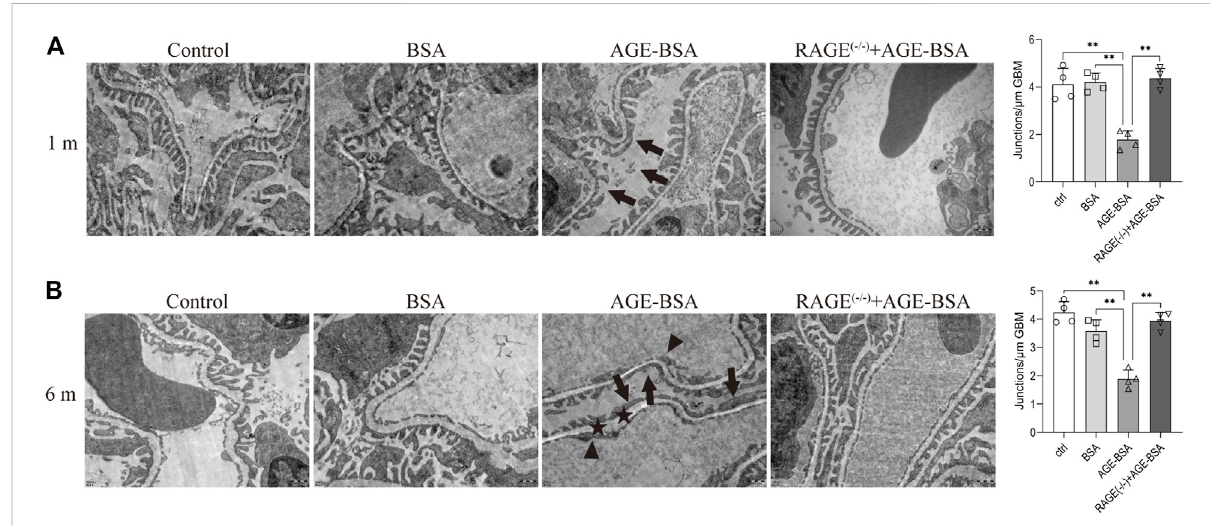
FIGURE 3 AGE-BSA induces RAGE-mediated ultrastructure alteration of podocytes and basement membrane in renal glomeruli. TEM of renal tissue was performed at 1 m (A) and 6 m (B) after treatment. The podocyte intercellular junction frequency was quantitatively analyzed (right panels). Arrow: podocytepseudopodia.Arrowhead:glomerularendothelialcells.Asterisk:basementmembrane.Scalebar=500 nm n =4.* p < 0.05and** p <